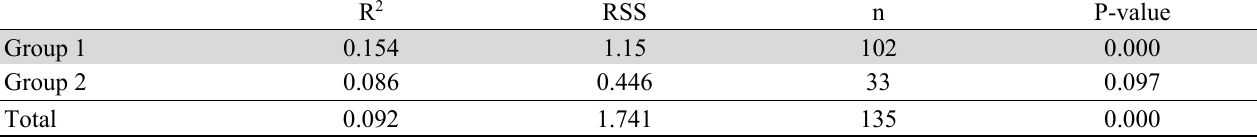
The sub-group and total R square, residual sum of square (RSS), number of the respondent (n), dan P-value R 2